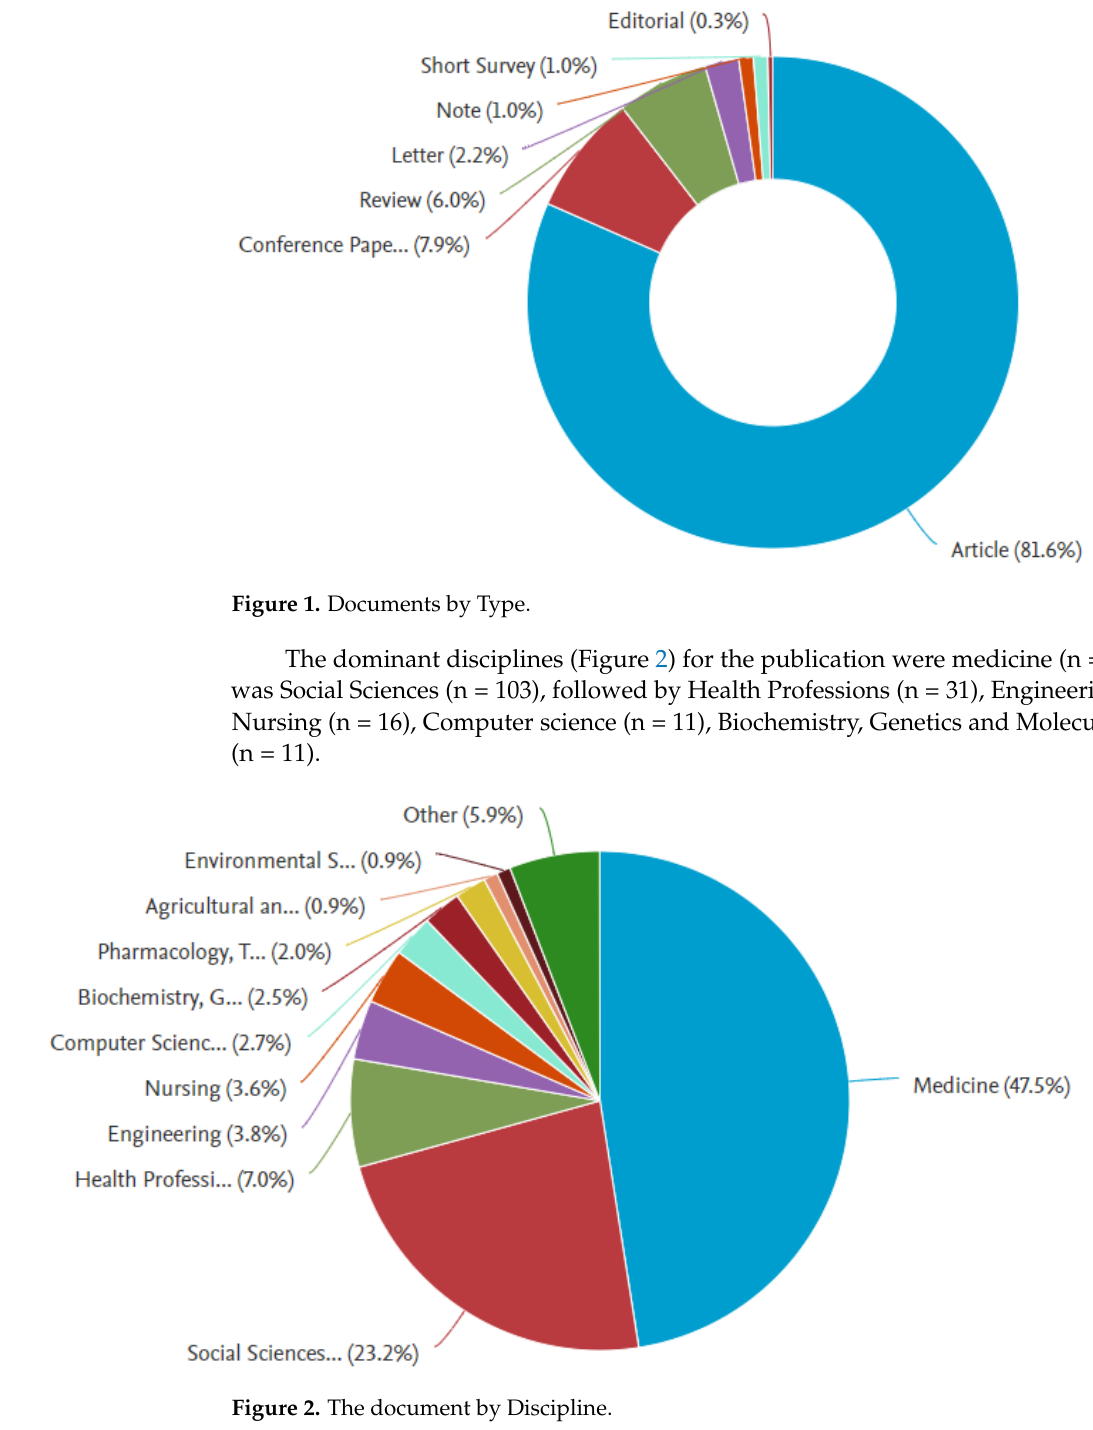
Figure 3. Annual publication growth of Performance evaluation of e-LMED.